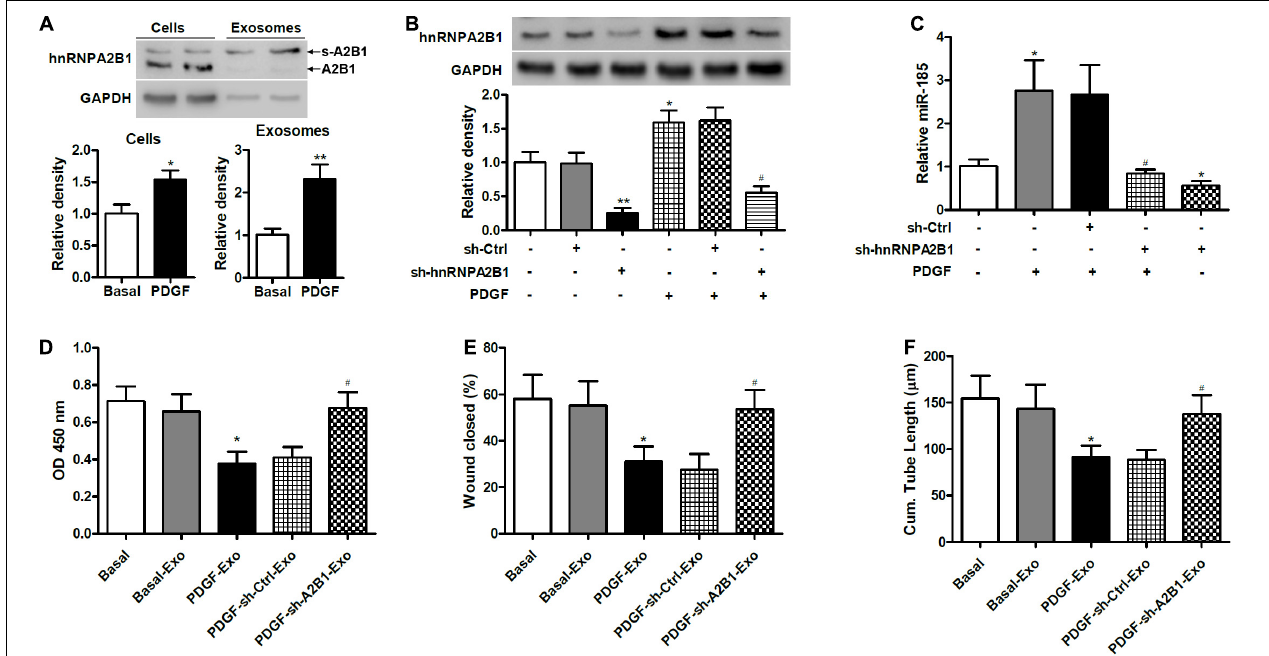
FIGURE 5 | Exosomal miR-185 transfer from VSMCs to ECs is modulated by hnRNPA2B1. (A) Western blot analysis of hnRNPA2B1 in VSMCs in basal condition and from VSMCs exposed to 20 ng/mL PDGF for 24 h and their exosomes. A2B1: hnRNPA2B1; s-A2B1: sumoylated hnRNPA2B1. * P < 0.05, ** P < 0.01. (B) Expression of hnRNPA2B1 in VSMCs transfected with control shRNA (sh-Ctrl) or hnRNPA2B1 shRNA (sh-hnRNPA2B1) carrying lentivirus for 24 h and then stimulated with PDGF for 24 h. * P < 0.05, ** P < 0.01 vs. control group, # P < 0.05 vs. PDGF group. (C) Expression of miR-185 in exosomes derived from VSMCs transduced with control shRNA (sh-Ctrl) or hnRNPA2B1 shRNA (sh-hnRNPA2B1) carrying lentivirus for 24 h and then stimulated with or without PDGF for 24 h. * P < 0.05 vs. control group, # P < 0.05 vs. PDGF group. (D) Proliferation of ECs treated with exosomes derived from VSMCs transduced with control shRNA (sh-Ctrl) or hnRNPA2B1 shRNA (sh-hnRNPA2B1) carrying lentivirus for 24 h and then stimulated with or without PDGF was assessed by a BrdU assay. (E) Migration of ECs treated with exosomes derived from VSMCs transfected with control shRNA (sh-Ctrl) or hnRNPA2B1 shRNA (sh-hnRNPA2B1) carrying lentivirus for 24 h